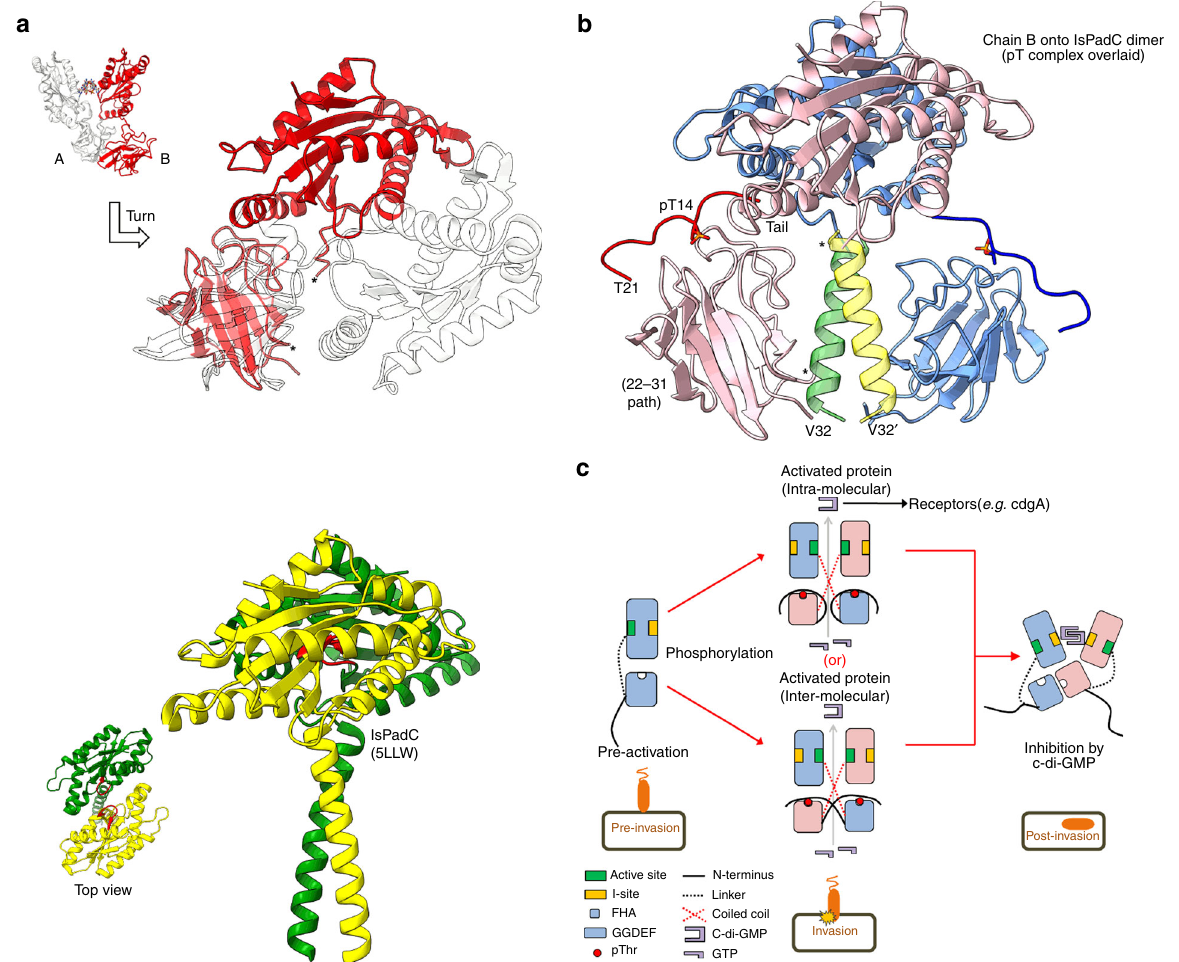
Fig. 6 Proposed model for DgcB activation. a Inset, DgcB representation as oriented in Fig. 1. This same representation (chain A white, transparent; chain B red) is re-oriented in main panel to demonstrate that the active state model in b is derived from chain B of our experimentally determined full-length structure. Lower panel, near-active GGDEF dimer of Is PadC (PDB 5LLW, sensory domains removed, individual chains yellow and green), displaying a conformation of coiled coils necessary to juxtapose the two active sites (red loop, top view). b ) Proposed model of active DgcB generated using composite structures. Chain B of DgcB (FHA and GGDEF, pink) was overlaid onto Is PadC dimer (generating a second chain of DgcB, colored blue). The activating coiled coil region of the Is PadC dimer is shown (green, yellow), situated between the FHA and GGDEF domains of DgcB (the termini of which are labeled with an asterisk, and presumed to lead into a similar coiled coil in the active form). The N-terminal phosphopeptide ligand from our complex structure is superimposed and shown in bold, with pT14 in stick form. T21 of the N-terminal tail and V32 of the FHA domain are labeled to demonstrate the likely path of the (missing) 10 linker residues. c Schematic for DgcB conformational states pre-, during and post-activation. Phosphorylation of residue T14 (from prey encounter-derived activation of a kinase) leads to either an intra- (top) or inter- (bottom) FHA:tail-driven GGDEF dimer (the model in b allows both and cannot be used to suggest which is more likely; non-reducing SDS-PAGE results of Fig. 5 suggest inter-dominates). This rearrangement results in productive association of the GGDEF active sites (dark green) and synthesis of c-di-GMP. The resultant c-di-GMP signals downstream invasion processes until an upper threshold is achieved and DgcB subsequently inhibited via I-site mediated feedback (I-site, orange block; as observed in our full-length structure). The Bdellovibrio bacteriovorus lifecycle stages corresponding to these events are represented below (predator orange, prey dark